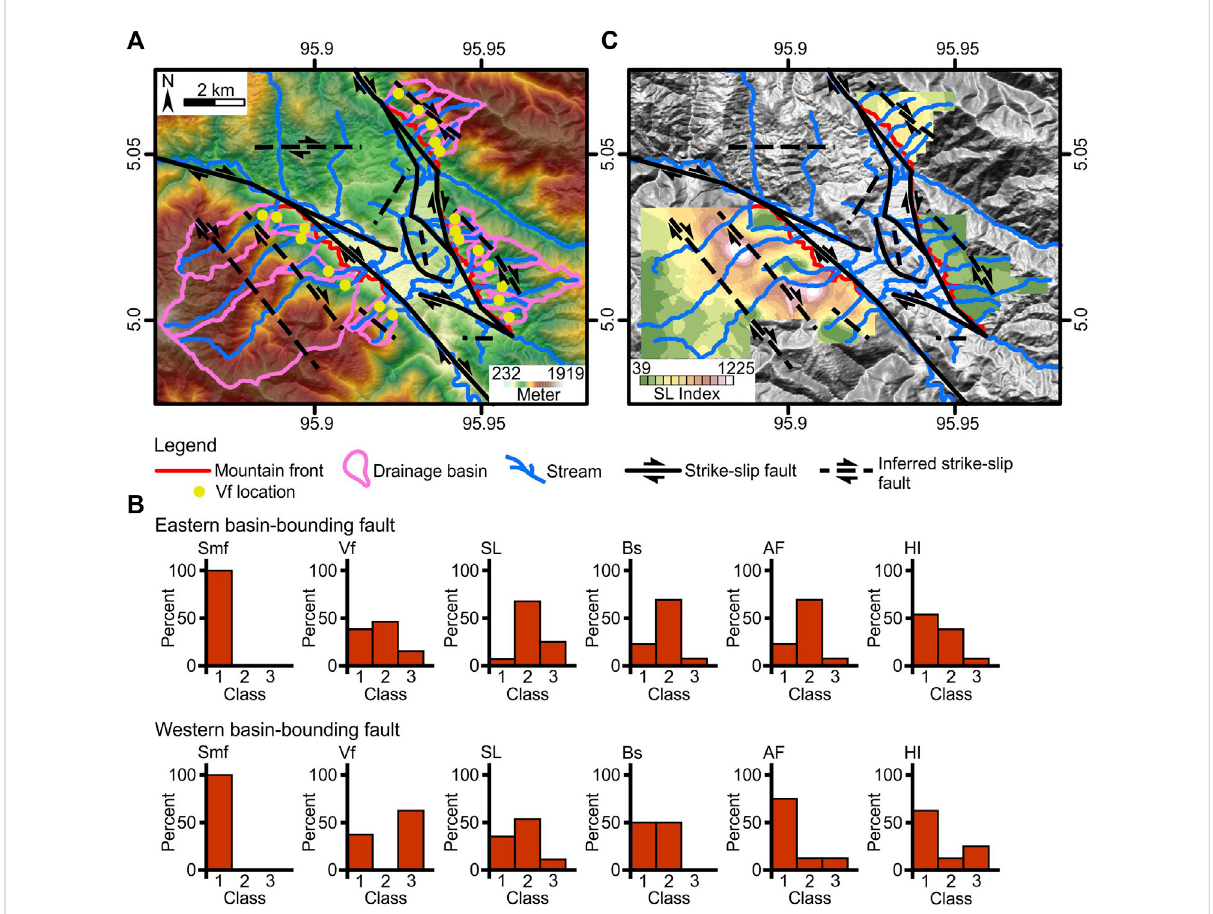
FIGURE 8 The Tangse Basin: (A) the mountain fronts, faults, and drainage basins, (B) classi fi cation of geomorphic indices, and (C) stream length- gradient